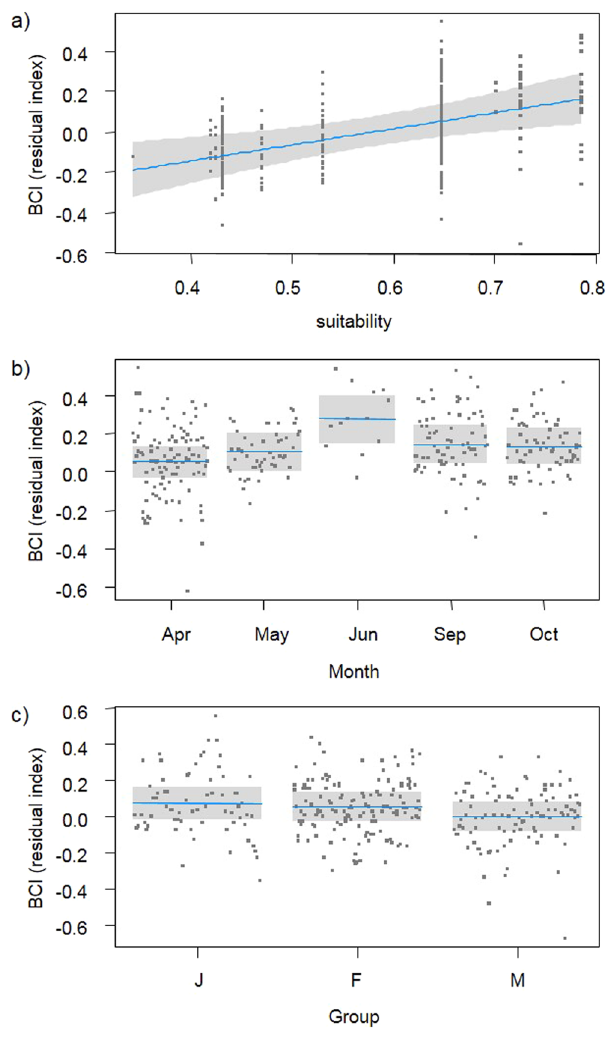
Figure 4. Partial regression plots of relationships between body condition index (BCI) and ( a ) environmental suitability; ( b ) month of survey; ( c ) age class and sex. Horizontal line represents mean values, while shaded box are 95%